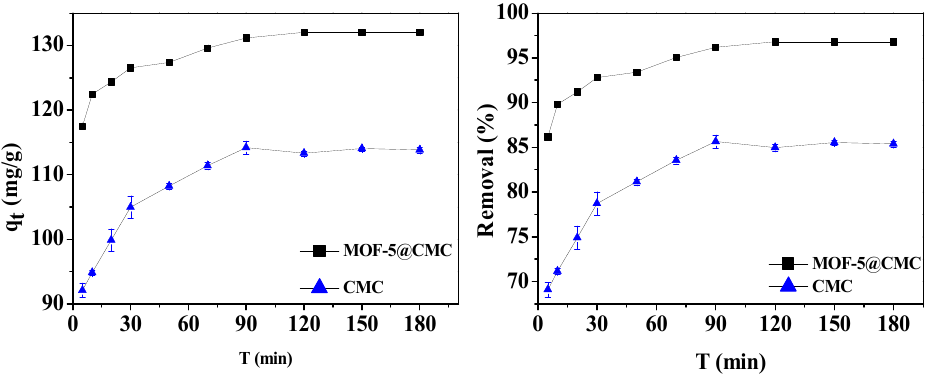
Figure 6. Adsorption capacity and removal rate as functions of contact time.